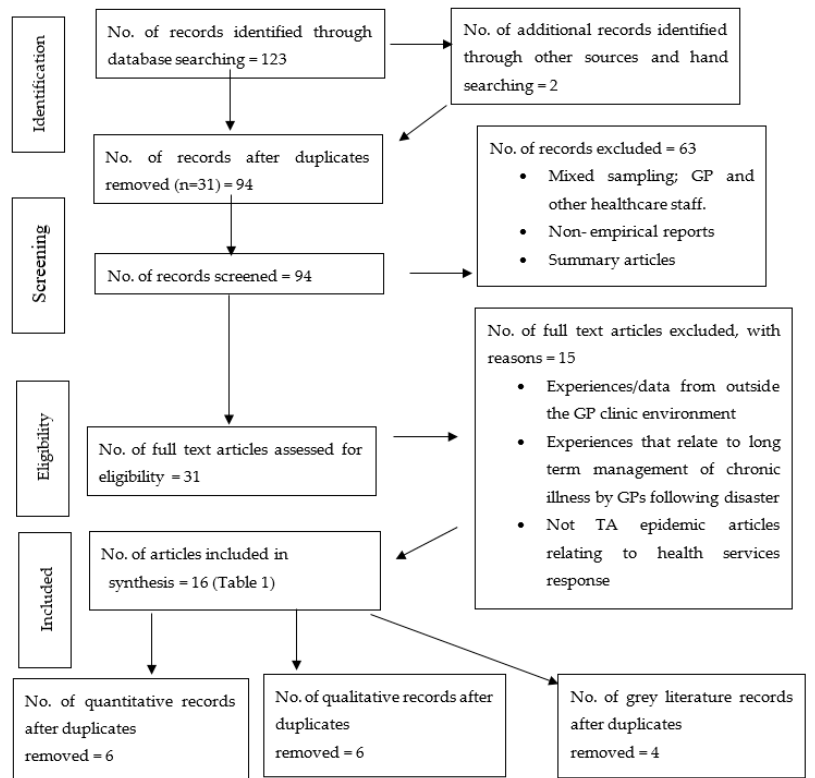
Figure 1. PRISMA flow chart of the study selection process.